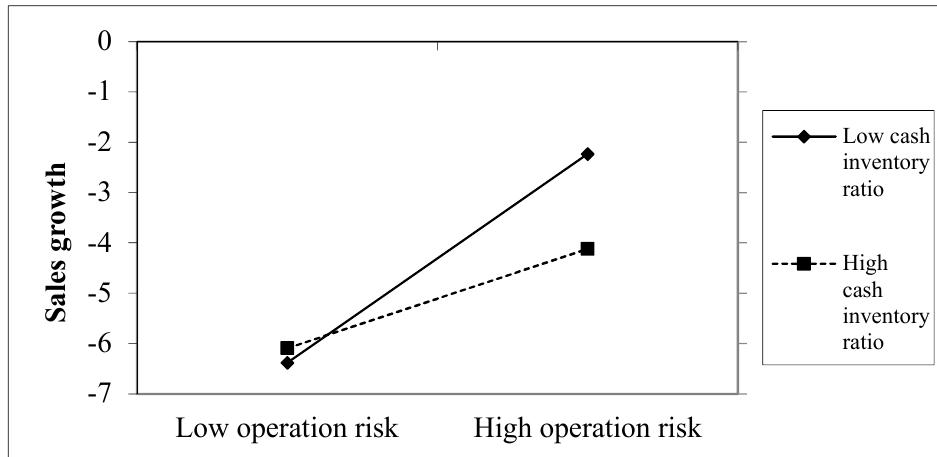
Figure 3. Interaction effect of operating risk and cash inventory ratio.